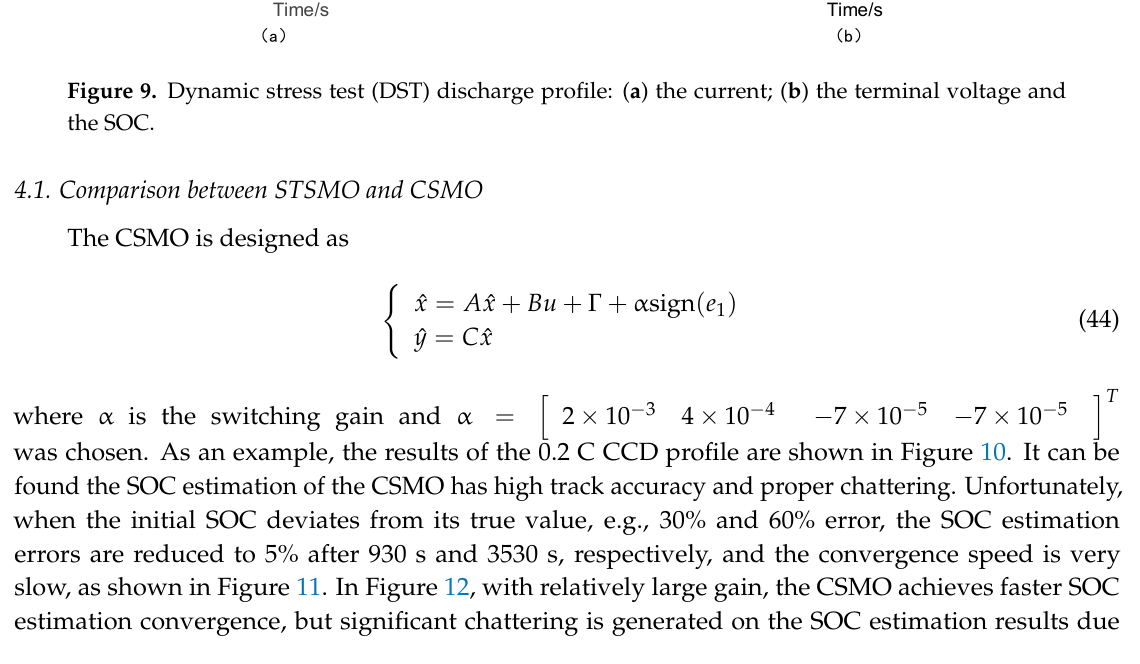
Figure 9. Dynamic stress test (DST) discharge profile: ( a ) the current; ( b ) the terminal voltage and the SOC.